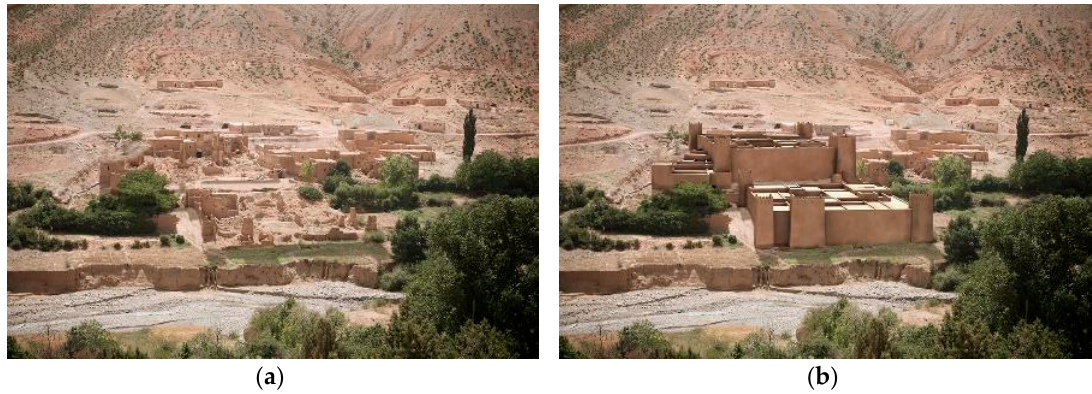
Figure 8. Tatiouine Ksar, Outat Valley. ( a ) At present; ( b ) Virtual reconstruction [20].